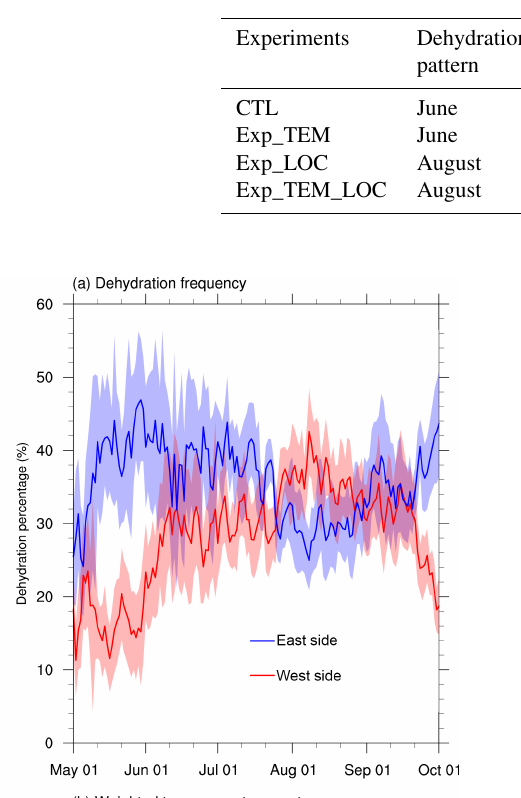
Table 1. Three idealized experiments based on traj_ERAi (values in bold) and traj_MERRA (values in brackets) to quantify the relative contributions of dehydration shift and dehydration temperatures on averaged water vapor over the Asian monsoon region.